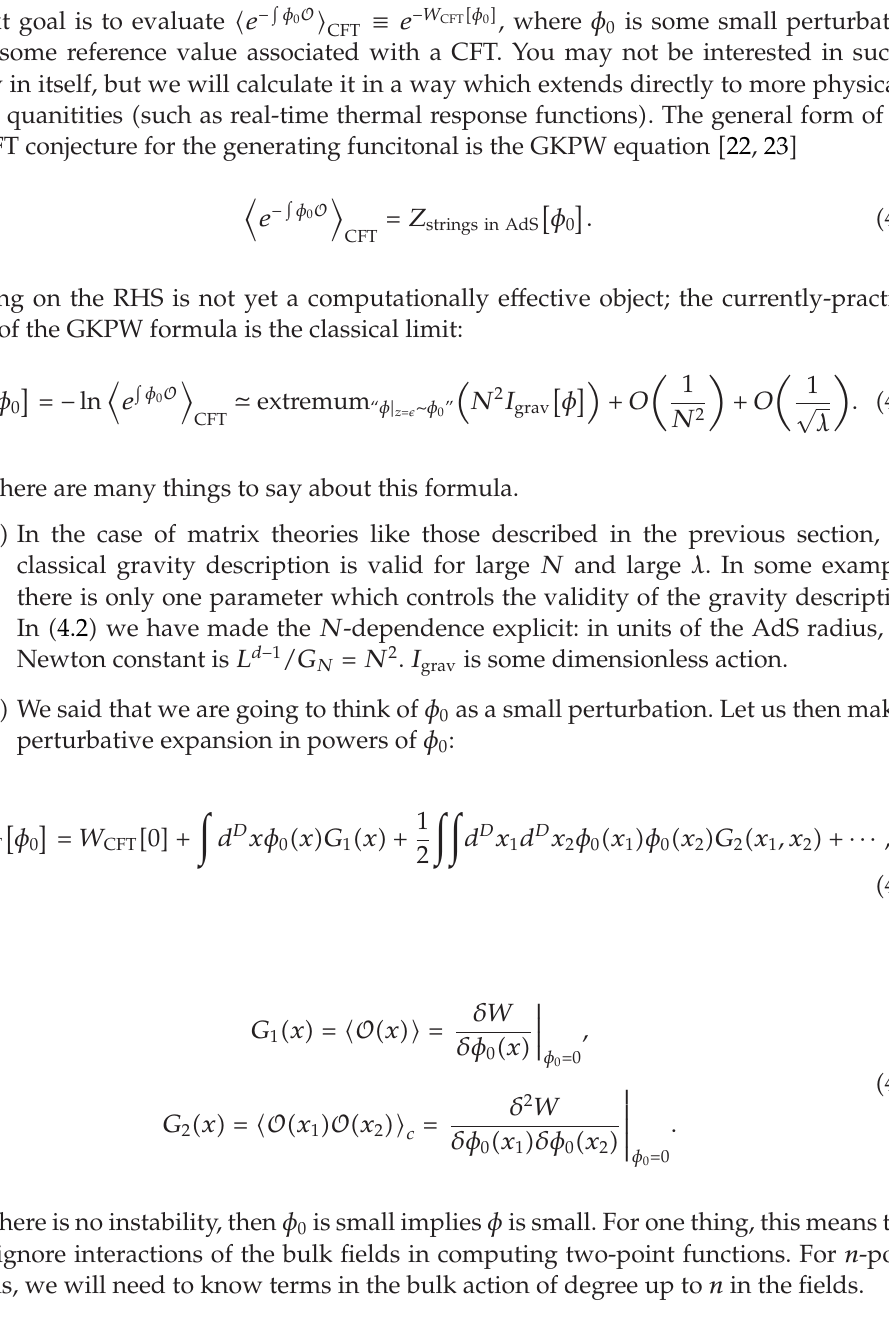
Figure 12: Propagator for SO (cid:2) N (cid:3) (cid:2)(cid:8)(cid:3) or Sp (cid:2) N (cid:3) (cid:2) − (cid:3) matrix